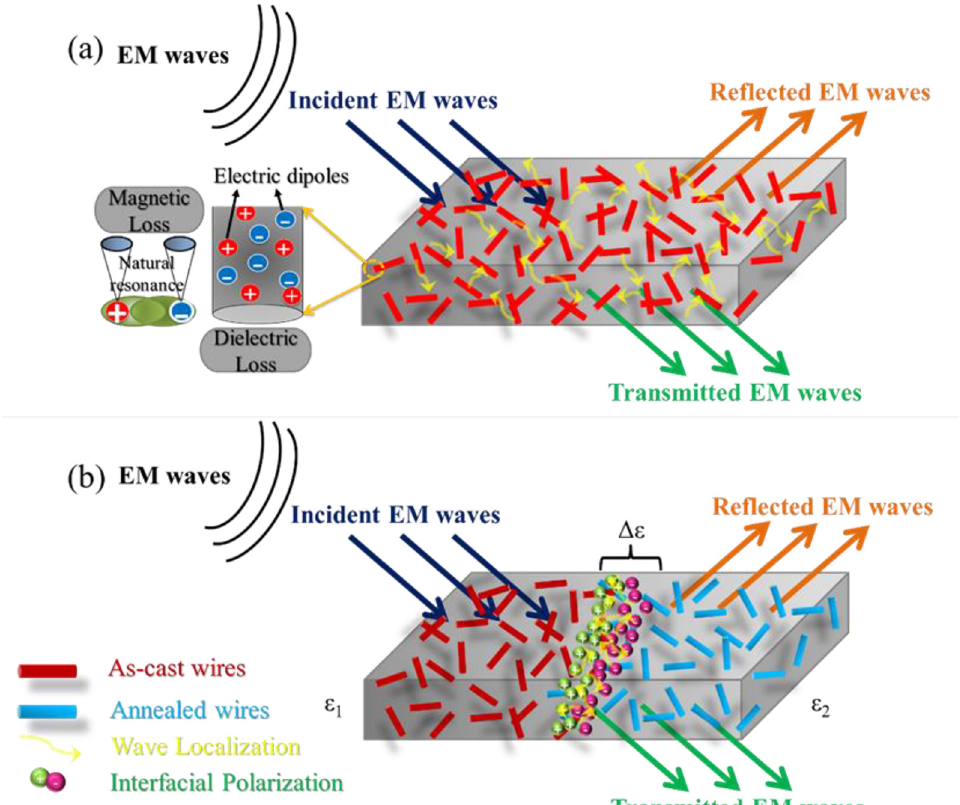
Fig. 7. Proposed scattering mechanisms in the randomly dispersed short-cut microwire composites: (a) composites containing the same type of wires; (b) composites containing as-cast wires and annealed wires in separated